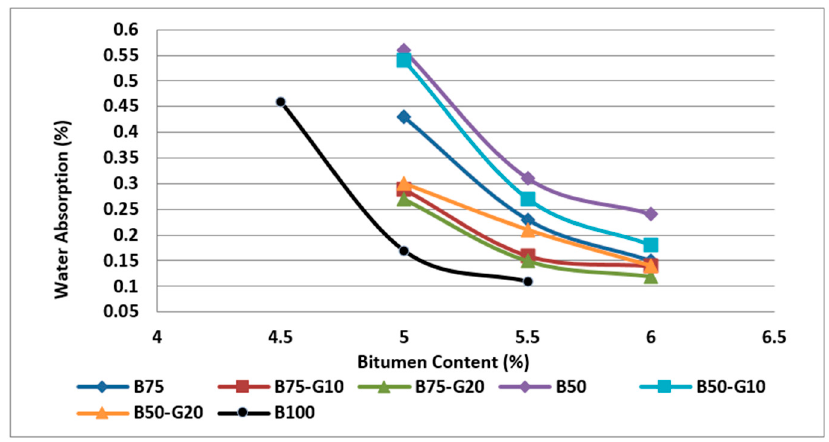
Figure 17. Comparison of water absorption in asphalt mixtures with different aggregate type.